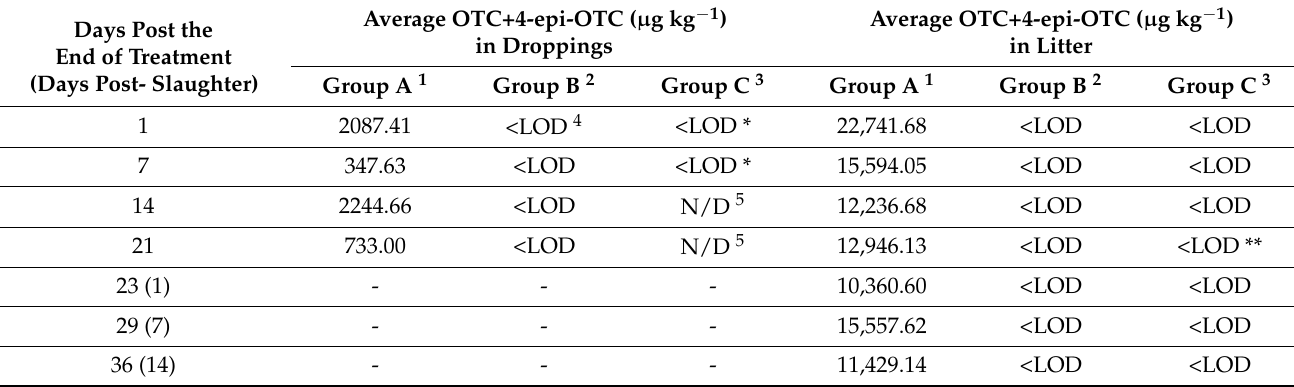
Table 2. OTC+4-epi-OTC concentrations in dropping and litter